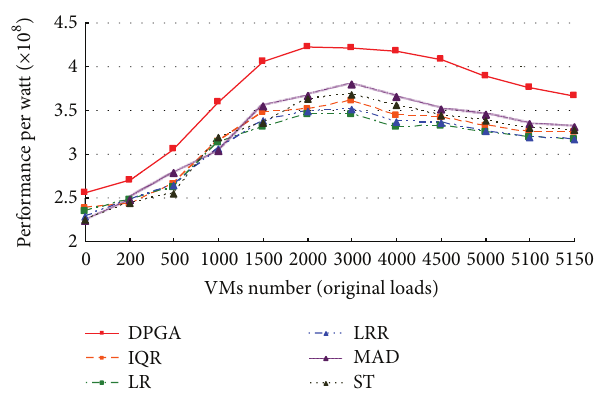
Figure 2: Comparison of performance per watt with different original